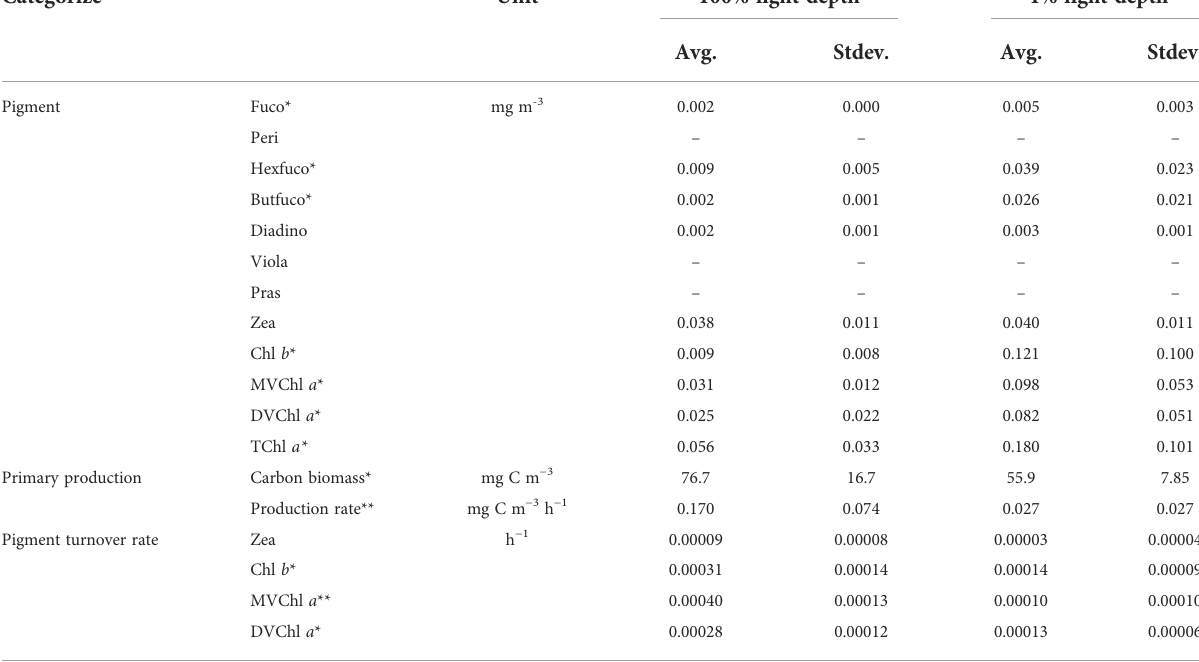
TABLE 2 Pigment concentrations, primary productions, pigment production rates, and pigment turnover rates between the 100% and 1% light depths in the Philippines Sea, Northwestern Paci fi c Ocean. Categorize